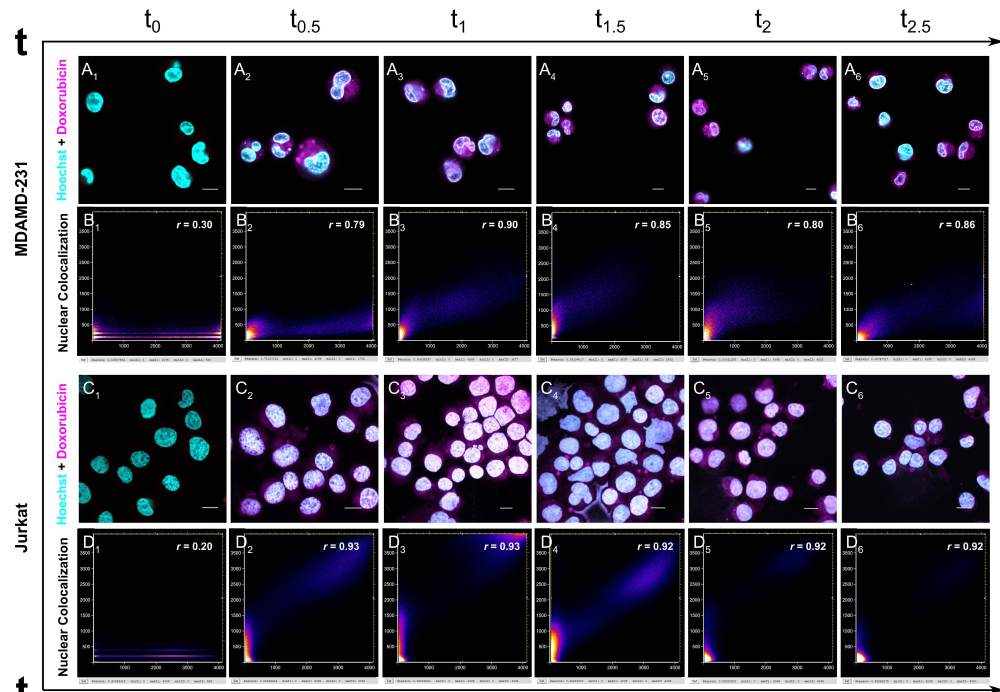
Figure 5. Cellular uptake and nuclear colocalization of doxorubicin in MDA ‐ MB ‐ 231 and Jurkat cells treated with doxorubicin (20 μ M) for 0, 0.5, 1, 1.5, 2, and 2.5 h. ( A , C ) confocal microscopy images of internalized doxorubicin (magenta) and nuclei (cyan) at different time points. ( B , D ) scatter plot of doxorubicin nuclear colocalization calculated by the colocalization finder plug ‐ in for ImageJ, r is Pearson’s correlation coefficient and r = 1 indicates complete colocalization.